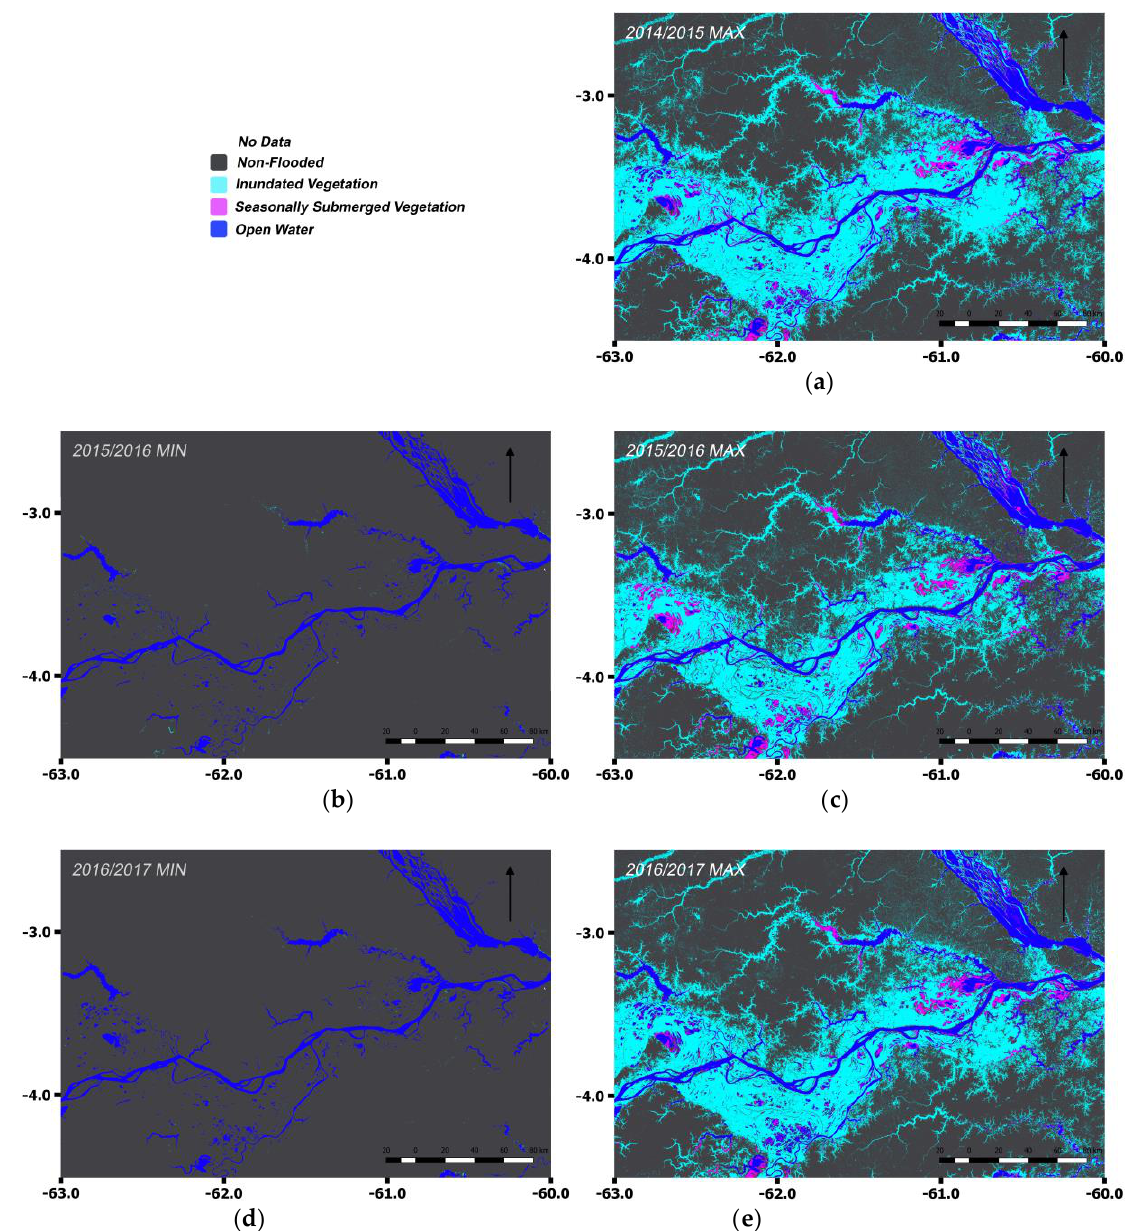
Figure 7. Minimum and maximum inundation extents over three hydrological years covering the region in the bounding box in Figure 6. Light blue: inundated vegetation, blue: open water; purple: seasonally submerged vegetation; grey: non-flooded; white: no data. ( a ) 2014 / 2015, ( b , c ) 2015 / 2016 and ( d , e ) 2016 /